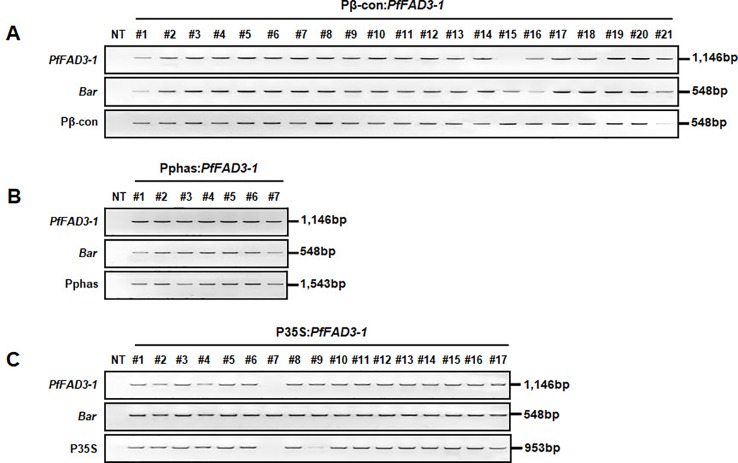
Confirmation of introduced genes from PfFAD3-1 transformants (T0) using PCR. Genomic DNA was extracted from Pβ-con:PfFAD3-1
(A), Pphas : PfFAD3-1
(B), and P35S:PfFAD3-1
(C) T0 transgenic leaf tissues. PfFAD3-1, PfFAD3-1 gene; Bar, Bar gene; Pβ-con, β-conglycinin promoter; Pphas, phaseolin promoter; P35S, CaMV 35S promoter; NT, non-transgenic plant; #1–#21 (part A), Pβ-con:PfFAD3-1 transgenic lines (T0); #1–#7 (part B), Pphas : PfFAD3-1 transgenic lines (T0); #1–#17 (part C), P35S:PfFAD3-1 transgenic lines (T0).